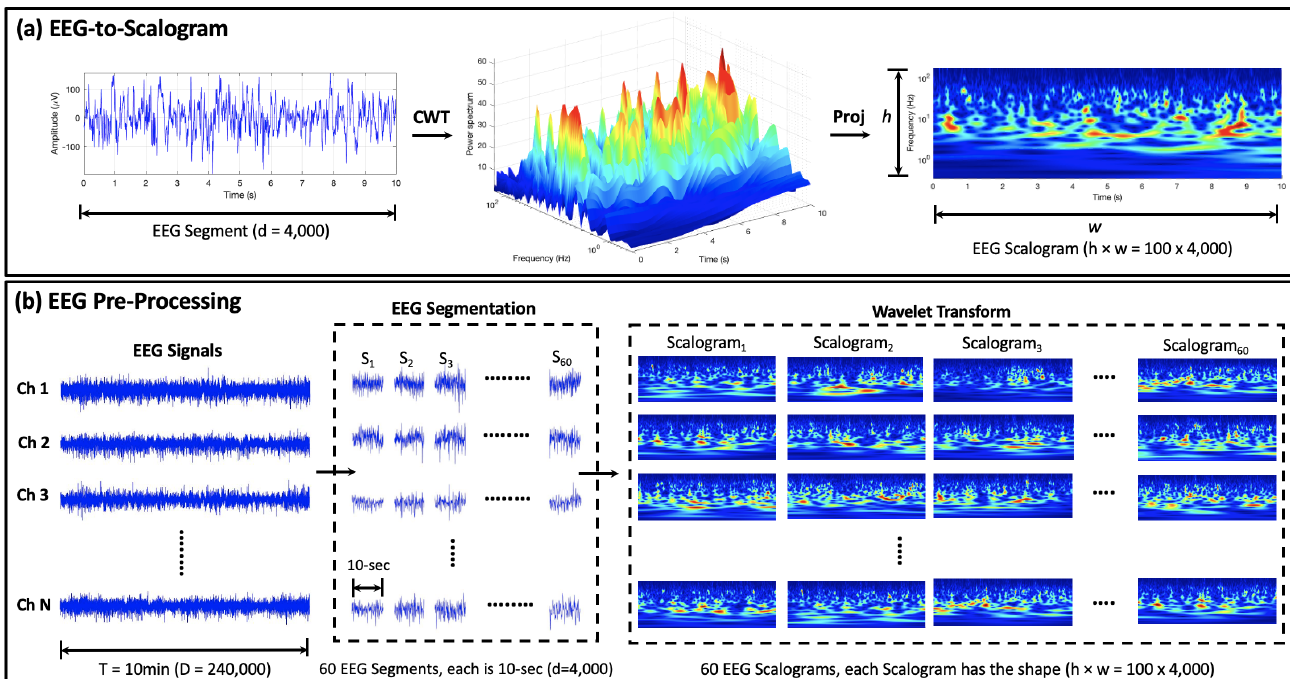
Figure 2. Schematic pipeline of the proposed EEG pre-processing strategy for seizure prediction: ( a ) EEG-to-scalogram conversion procedure: continuous wavelet transform (CWT) is adopted to generate the EEG power spectrum from the time-series EEG data; and 3D-to-2D projection (Proj) is used to produce the 2D time-frequency representations of EEG named “scalogram”. ( b ) EEG pre-processing approach: S 1 , S 2 , · · · , S 60 correspond to the 1st, 2nd, and 60th 10-s segments of each 10-min EEG clip ( f S = 400 Hz); N is the total number of EEG channels ( N = 23 for scalp EEG; N =